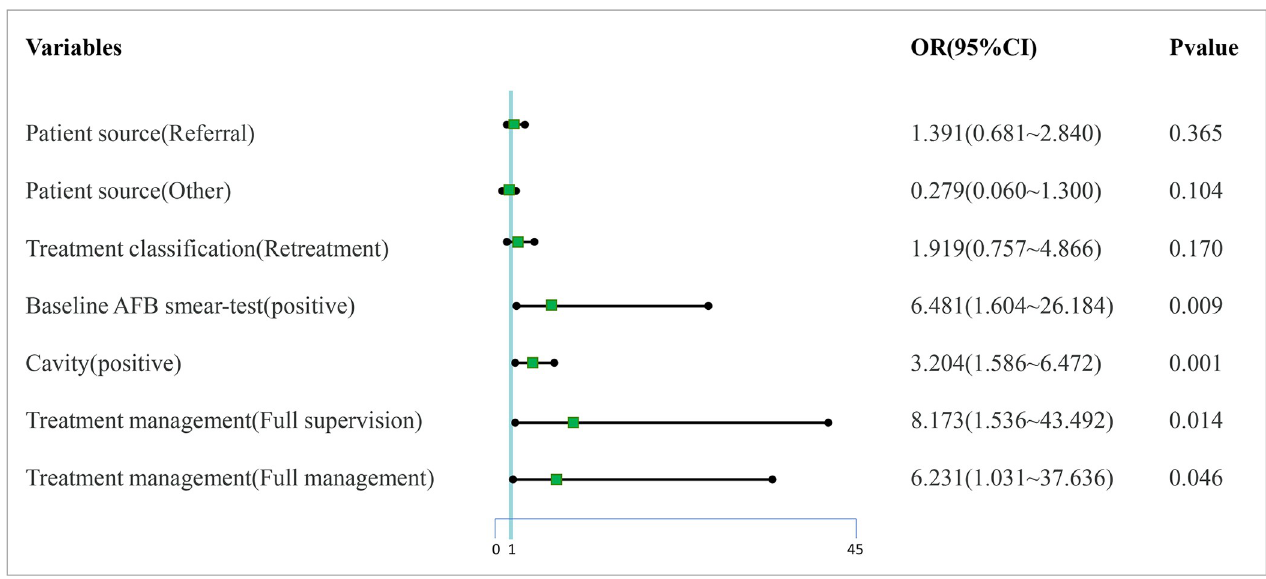
Fig 2. The result of logistic regression.